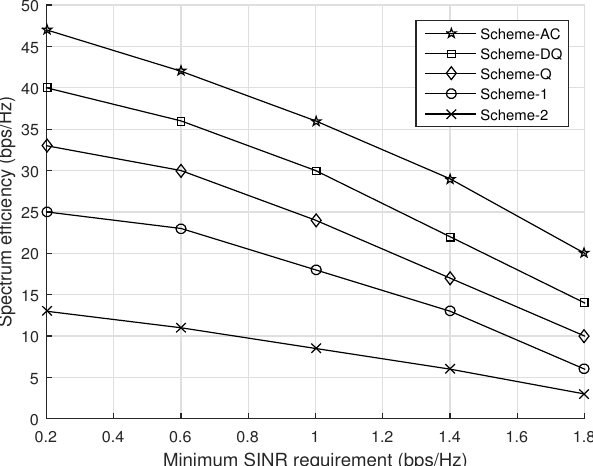
Figure 7. SE versus minimum SINR requirement for D2D pairs.